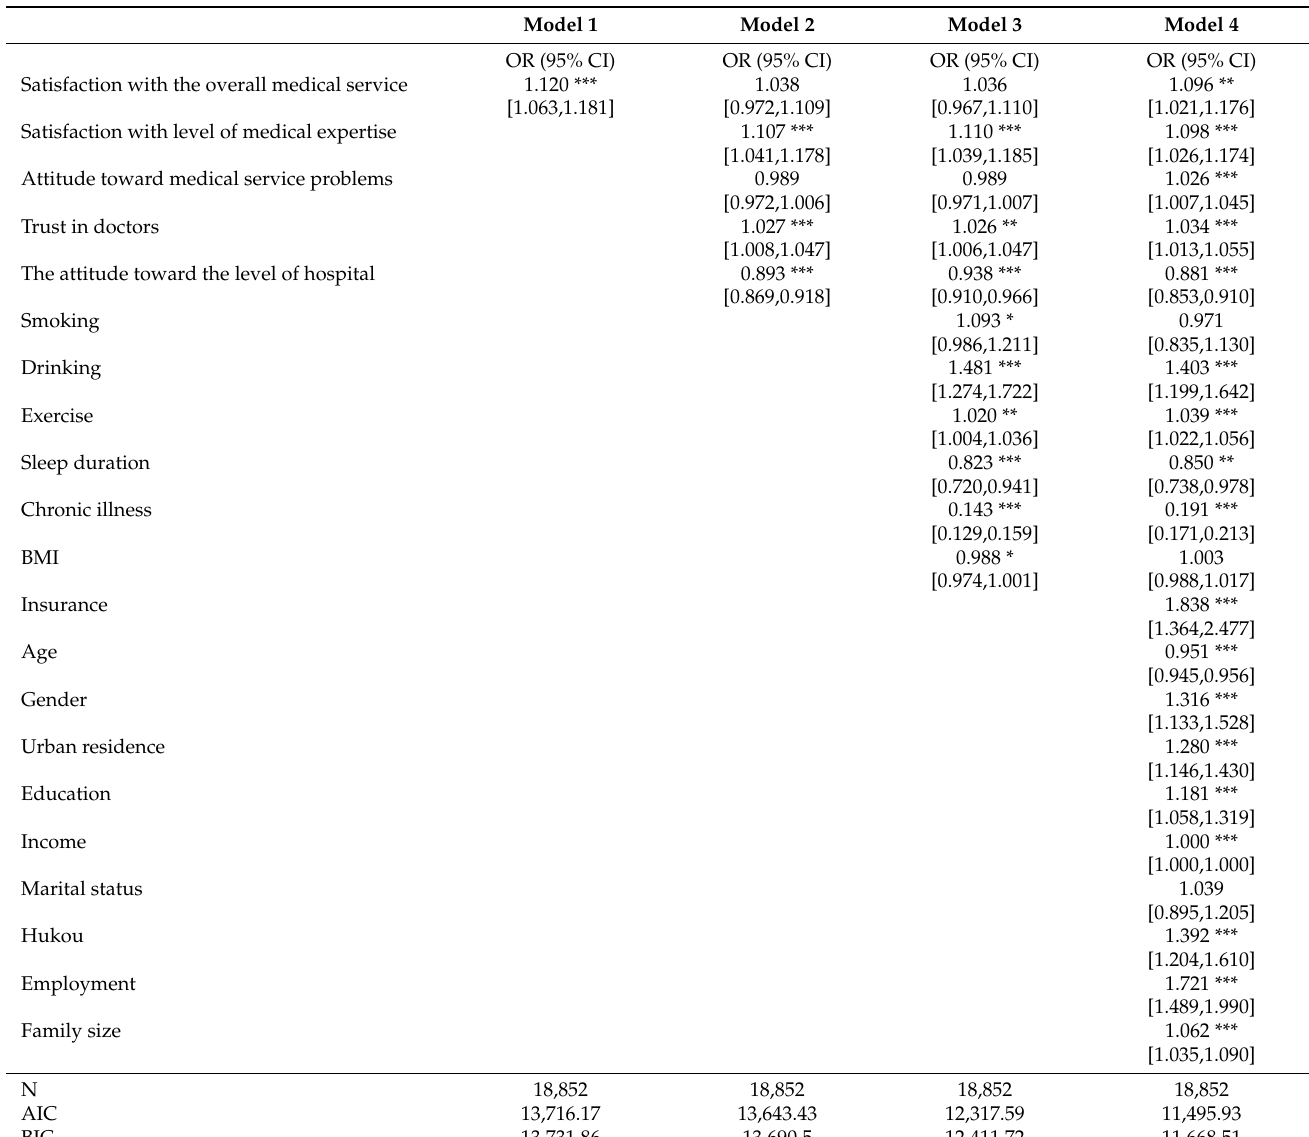
Table 2. Logistics regression model predicting good SRH with odds ratio (OR) and 95% confidence intervals